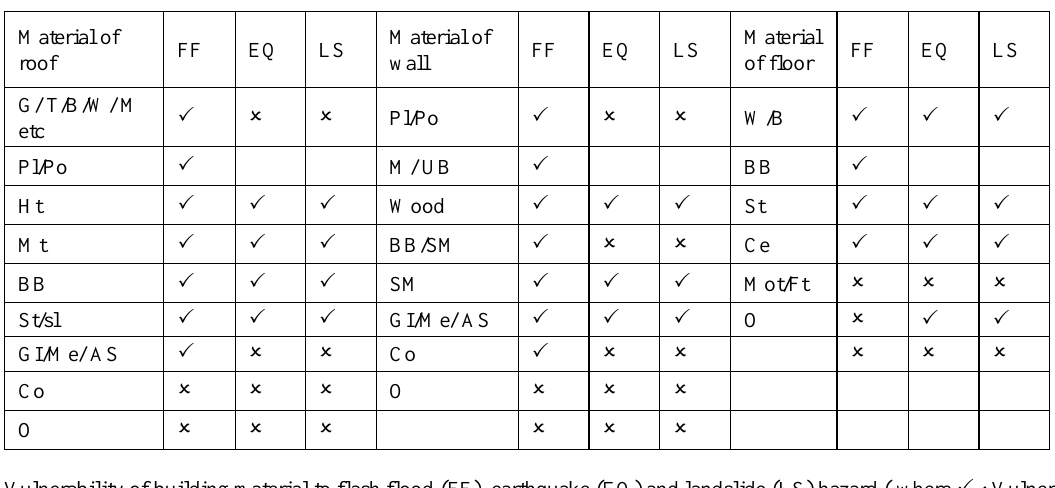
Table 5. Vulnerability of building material to flash flood (FF), earthquake (EQ) and landslide (LS) hazard ( where  : Vulnerable,  : Non- vulnerable, G: Glass, T: Thatch, B: Bamboo, M: Mud, Pl: Plastic, Po: Polythene, Ht: Handmade tiles, Asbestos sheets: AS, Me: Metal, W: Wood, Ce: Cement, B: Bamboo, Mt: Machine made tiles, UB: Unburnt brick, BB: Burnt brick, St: Stone, SM: Stone packed with mortar, Sl: Slate, Mot: Mosaic Tiles, Ft: Floor tiles, As: Asbestos sheets, Co: Concrete, O: Any other material) Analysis of final composite index data obtained at village